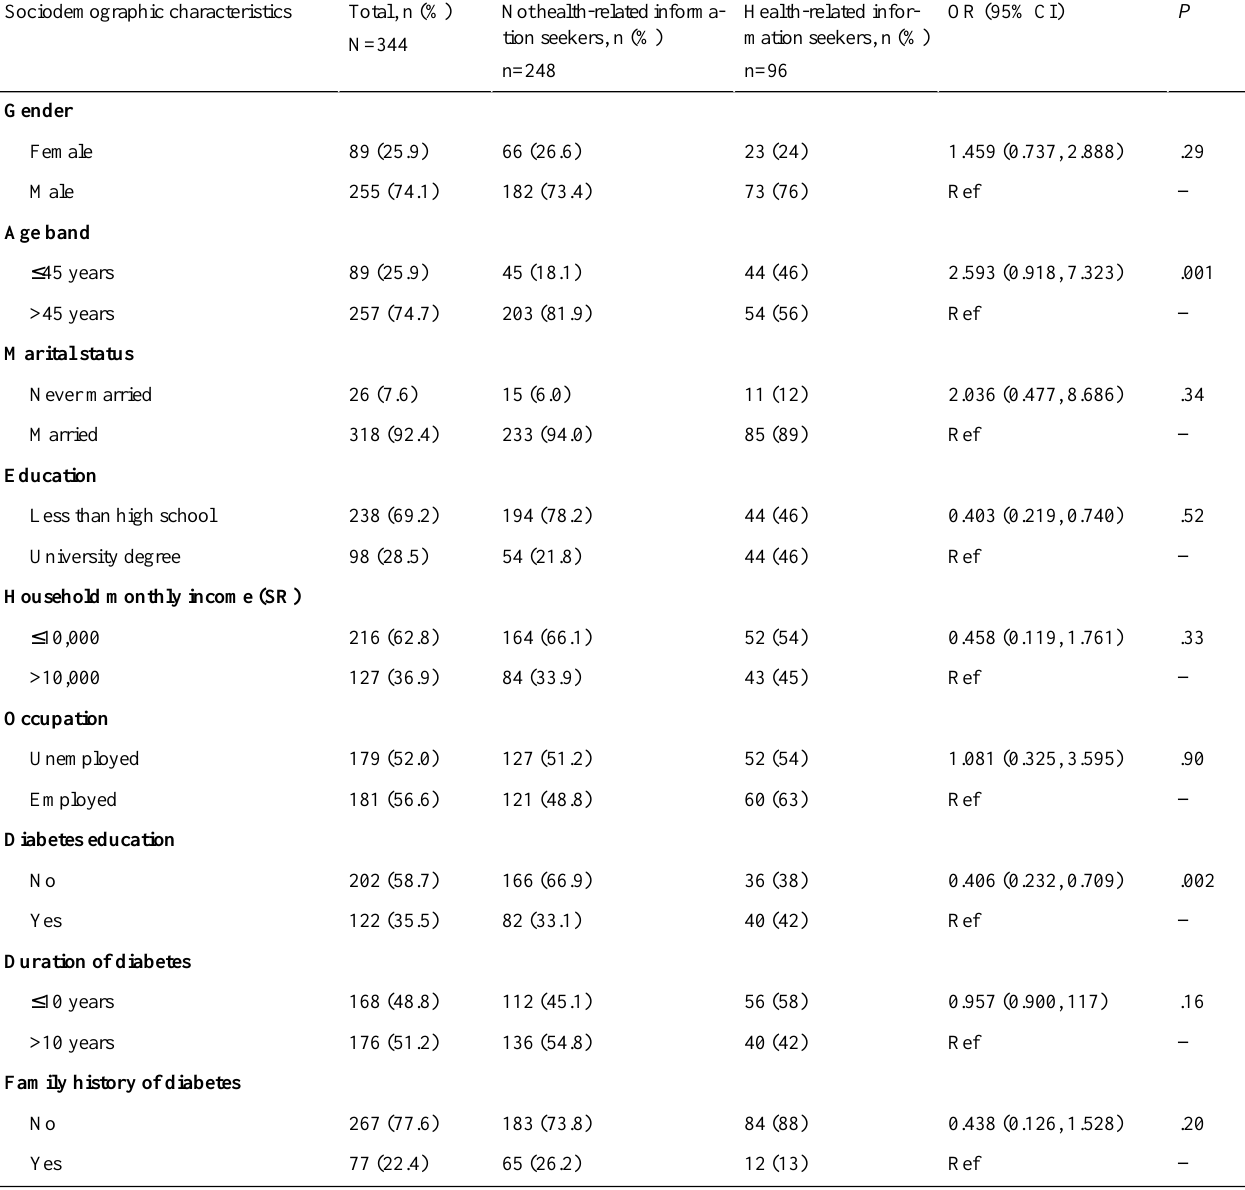
Table 4. Logistic regression (N=344 full case data only) modeling odds for nononline health-related information seekers versus online health-related information seekers with sociodemographic